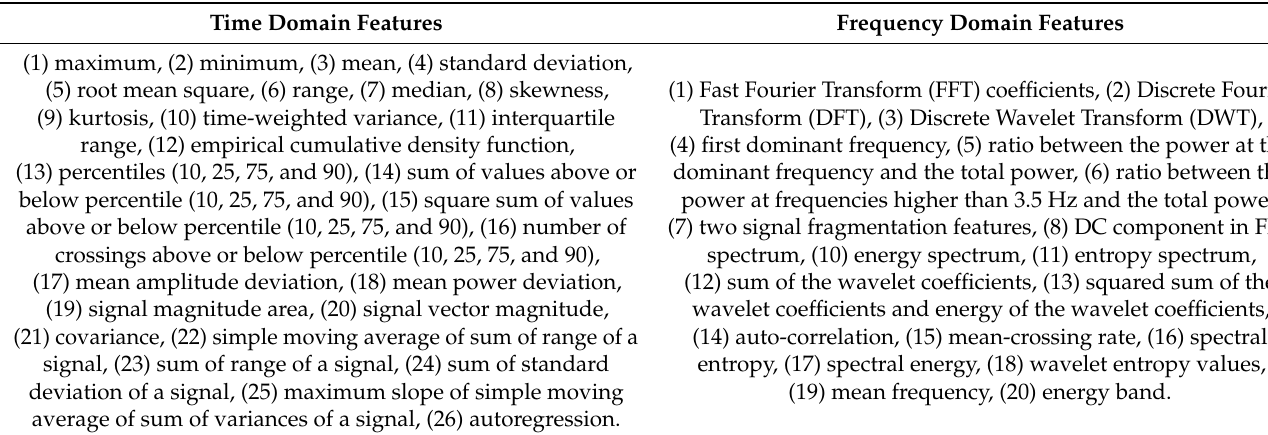
Table 1. Most used time and frequency-domain